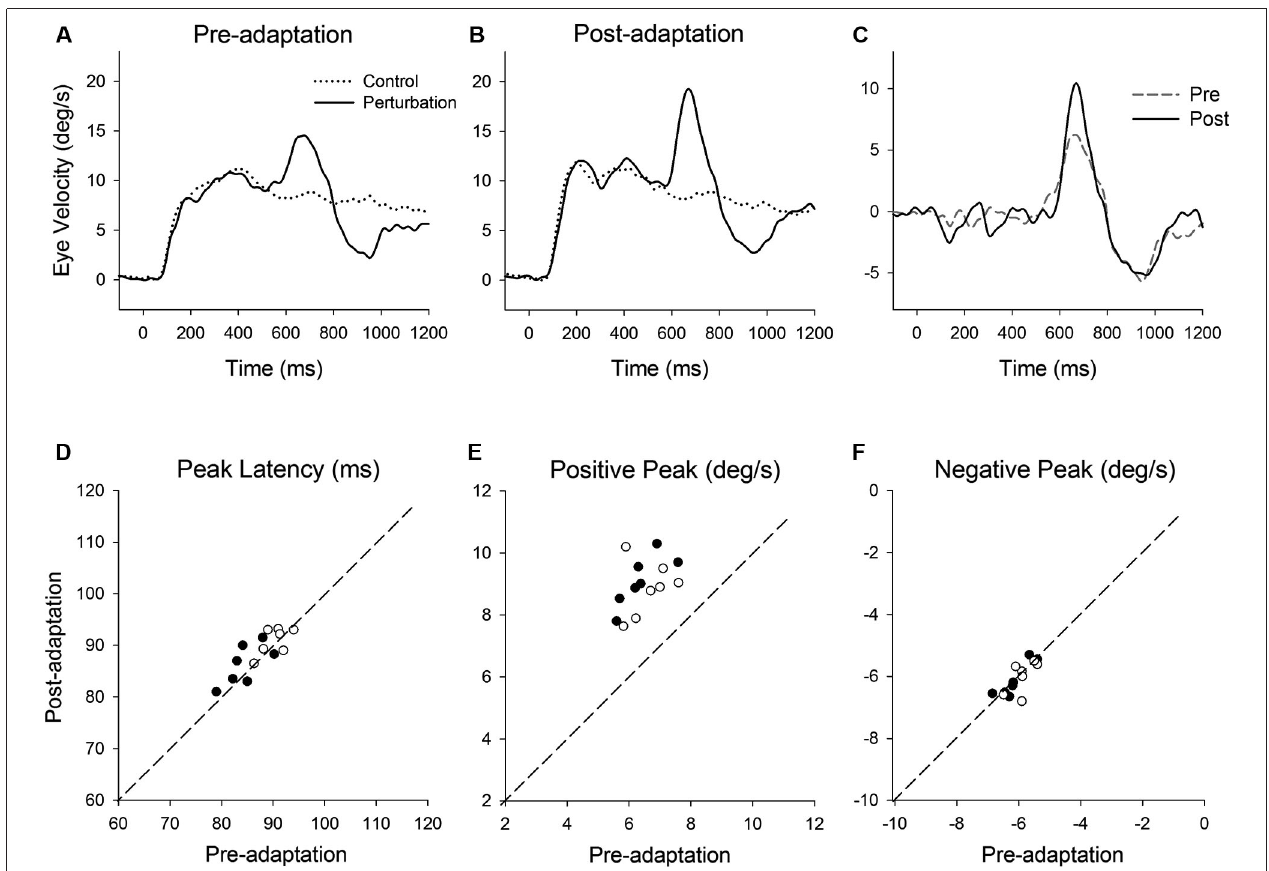
(D–F) Summaries of the perturbation responses for 14 experiments of gain-increase adaptation for two monkeys. (D) Mean values of perturbation latency, (E) positive peak velocity and (F) negative peak velocity are shown pre- and post-adaptation. Open and filled symbols indicate monkey-P and B,